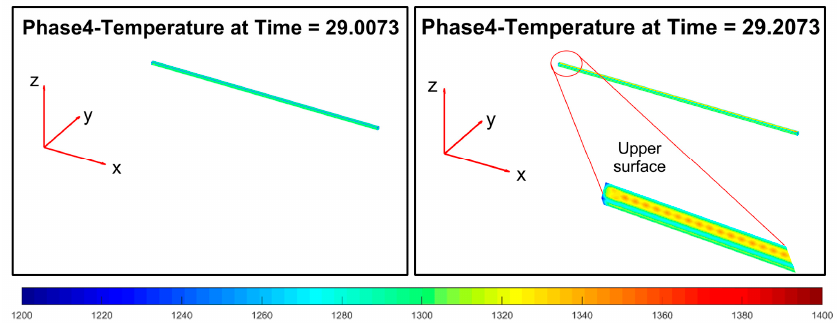
Figure 15. Modelization: phase 3 (movement between the descaler and stand 1).